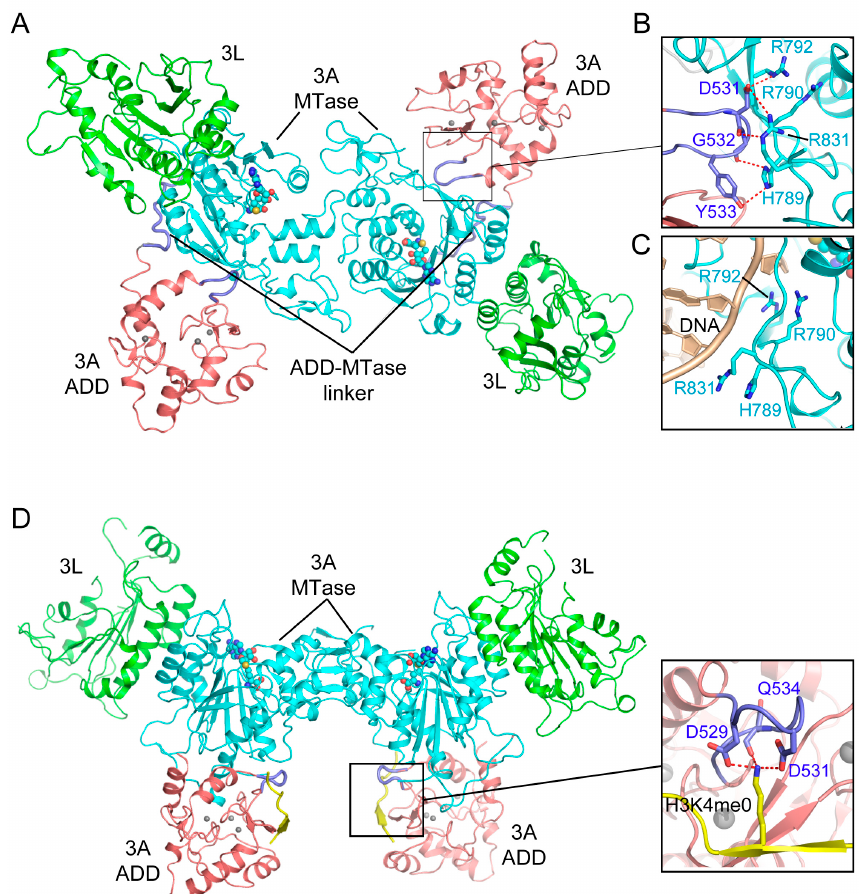
Figure 7. Structural analysis of the Atrx-Dnmt3-Dnmt3l (ADD) domain-mediated DNMT3A autoinhibition. ( A ) Structural overview of the DNMT3A-DNMT3L tetramer, with the DNMT3A fragment comprised of both the ADD and MTase domains (PDB 4U7P). ( B ) Intramolecular interactions between the ADD loop (blue) and the MTase domain (aquamarine) of DNMT3A. The hydrogen bonding interactions are depicted as dashed lines. ( C ) The ADD-binding site of the DNMT3A MTase overlaps with its DNA binding site. ( D ) Structure of the DNMT3A-DNMT3L tetramer bound to the histone H3K4me0 peptide (PDB 4U7T), with the interaction between H3K4me0 and the ADD domain shown in an expanded view (PDB 3A1B).